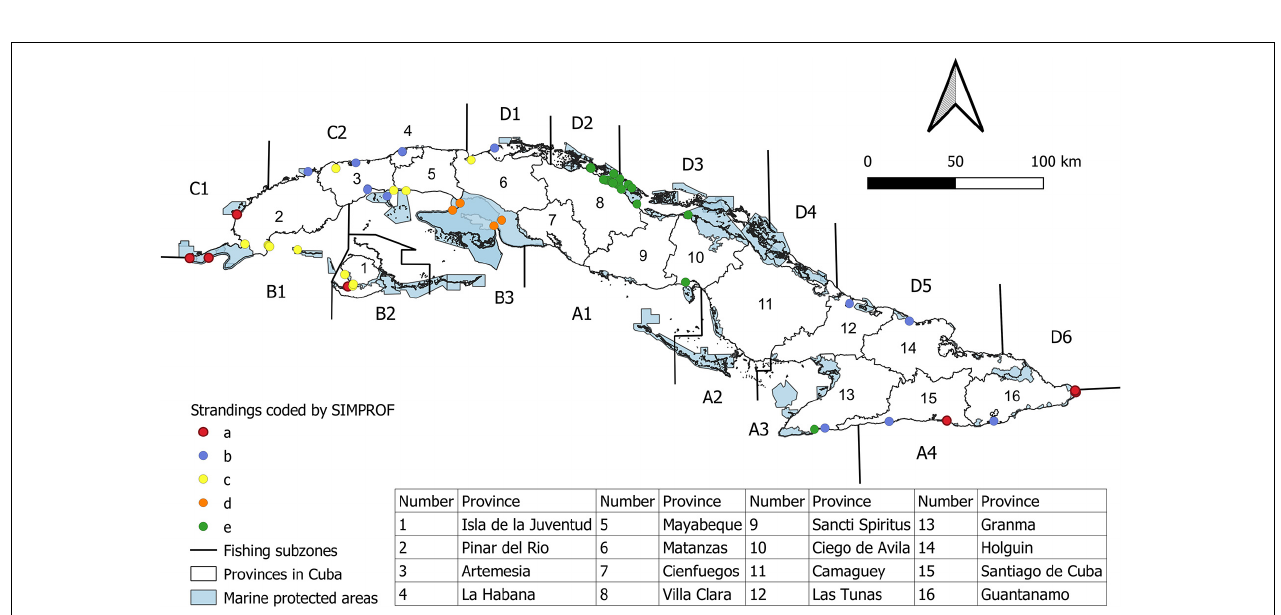
FIGURE 1 | A map showing mortalities of manatees. Colored dots = events categorized in five groups (a–e) generated by a similarities profile analysis (SIMPROF), letters followed by numbers = fishing subzones, blue-shaded areas = approved marine protected areas, and numbers = provinces as listed in the table. Some colored dots overlap because mortalities occurred at the same place at different